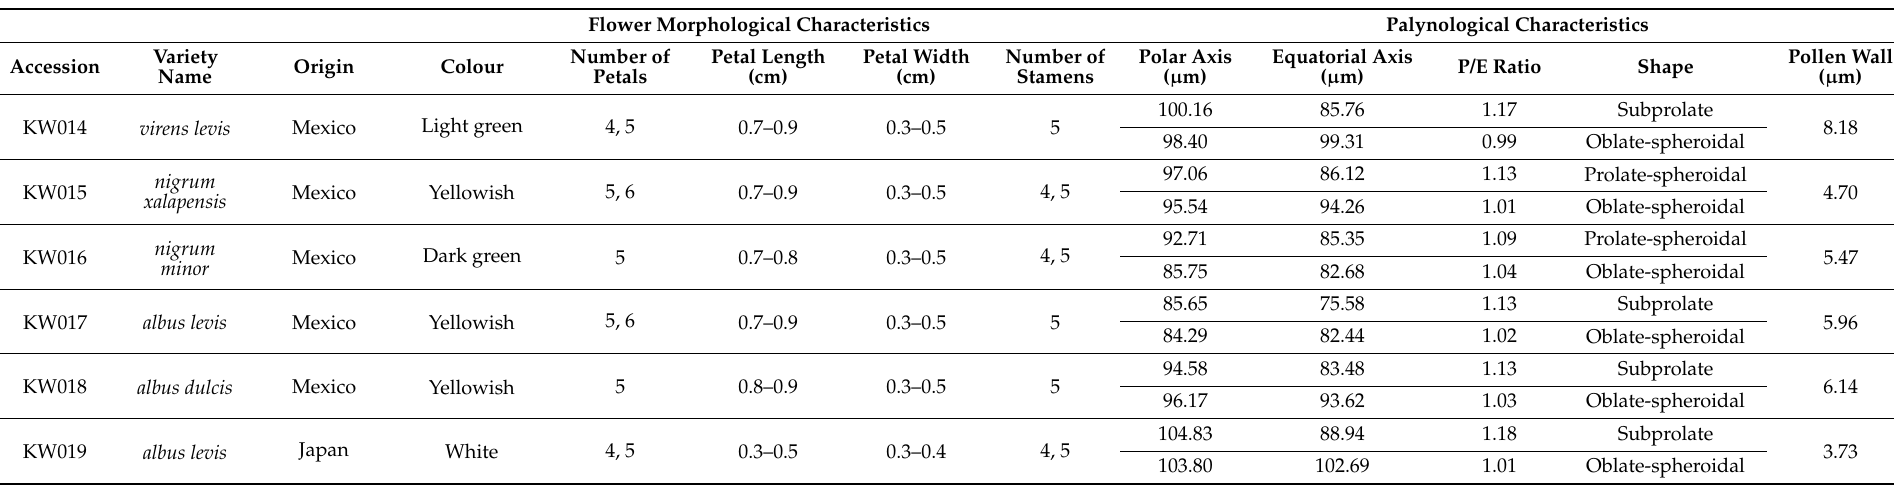
Table 1. The comparative flower morphological and palynological characteristics of 1 Japanese and 5 Mexican S. edule